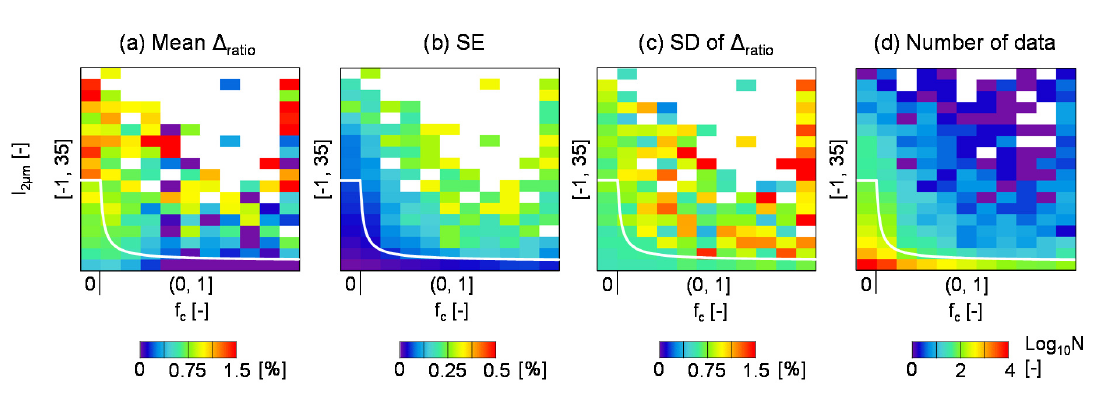
Figure 2. Variation of the relative difference in the ratio component between GOSAT and TCCON ( Δ ratio ) according to the cloud fraction (f c ) and the normalized 2 μ m band radiance (I 2 μ m ). Data with 0 < f c ≤ 1 were divided into 10 bins (horizontal axis), and data with − 1 ≤ I 2 μ m ≤ 35 were divided into 18 bins (vertical axis). The mean Δ ratio , standard error (SE) calculated by the precision of single data (( a ) and ( b )), standard deviation (SD) of Δ ratio ( c ), and number of data points ( d ) for each bin are presented. Data with Normalized Difference Snow Index (NDSI) ≤ 0.4 were used. Only bins having more than two data points are colored except in panel ( d ). The white line indicates the cloud screening criterion (Section 4.3).